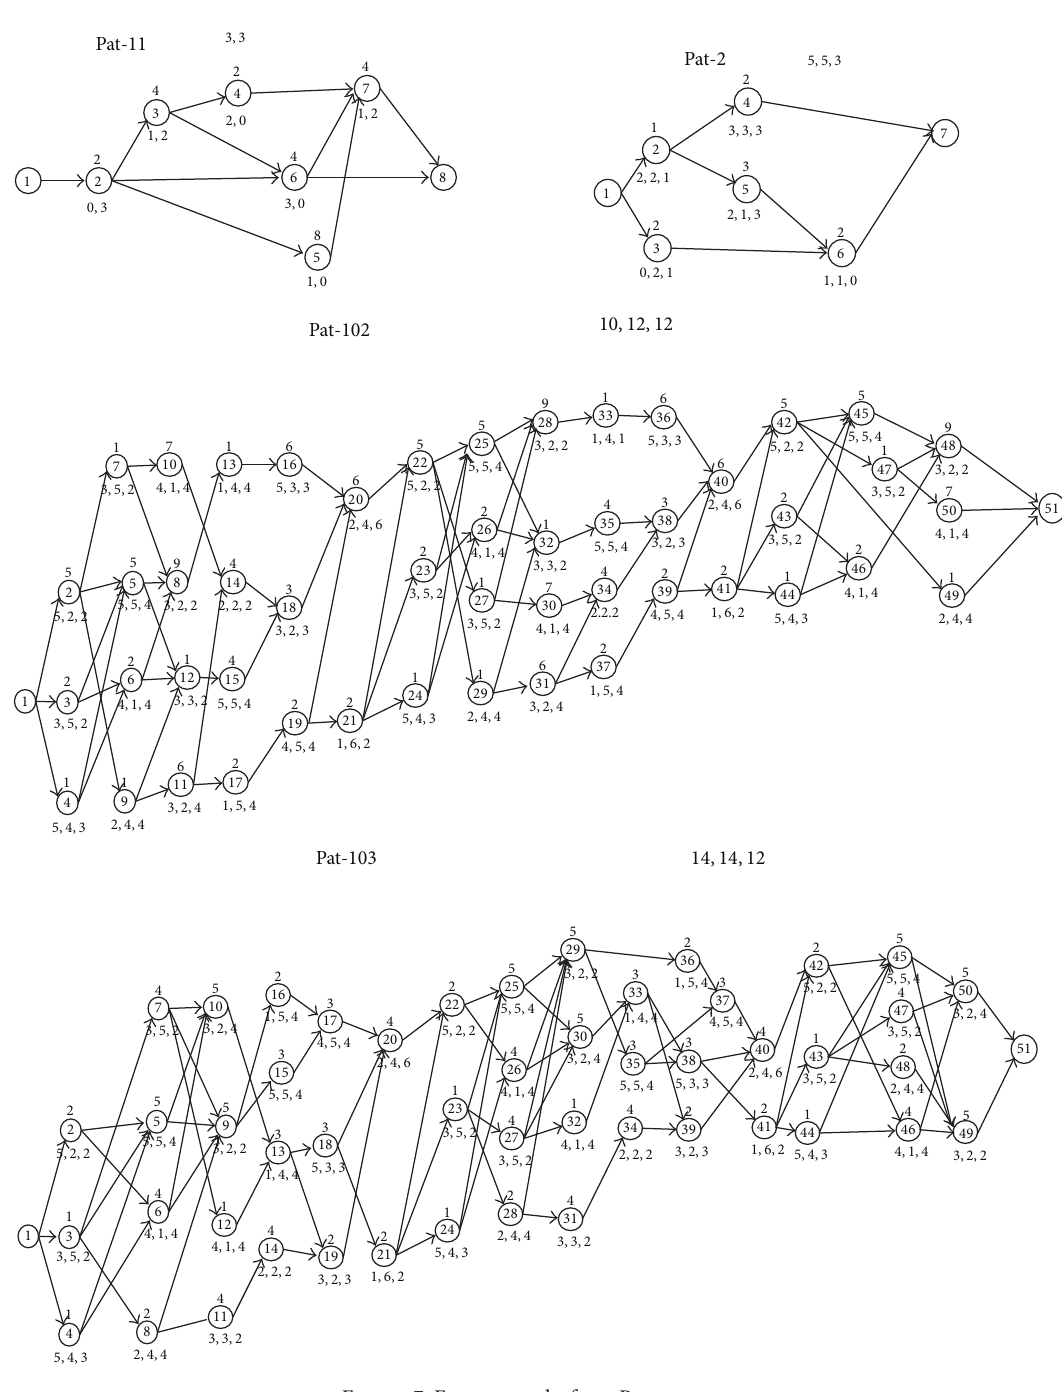
Figure 7: Four networks from Patterson